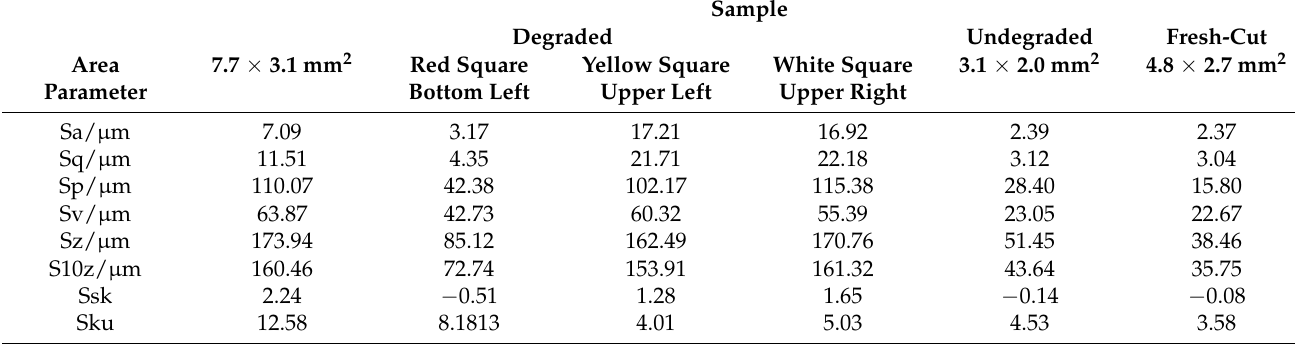
Table 4. Surface roughness